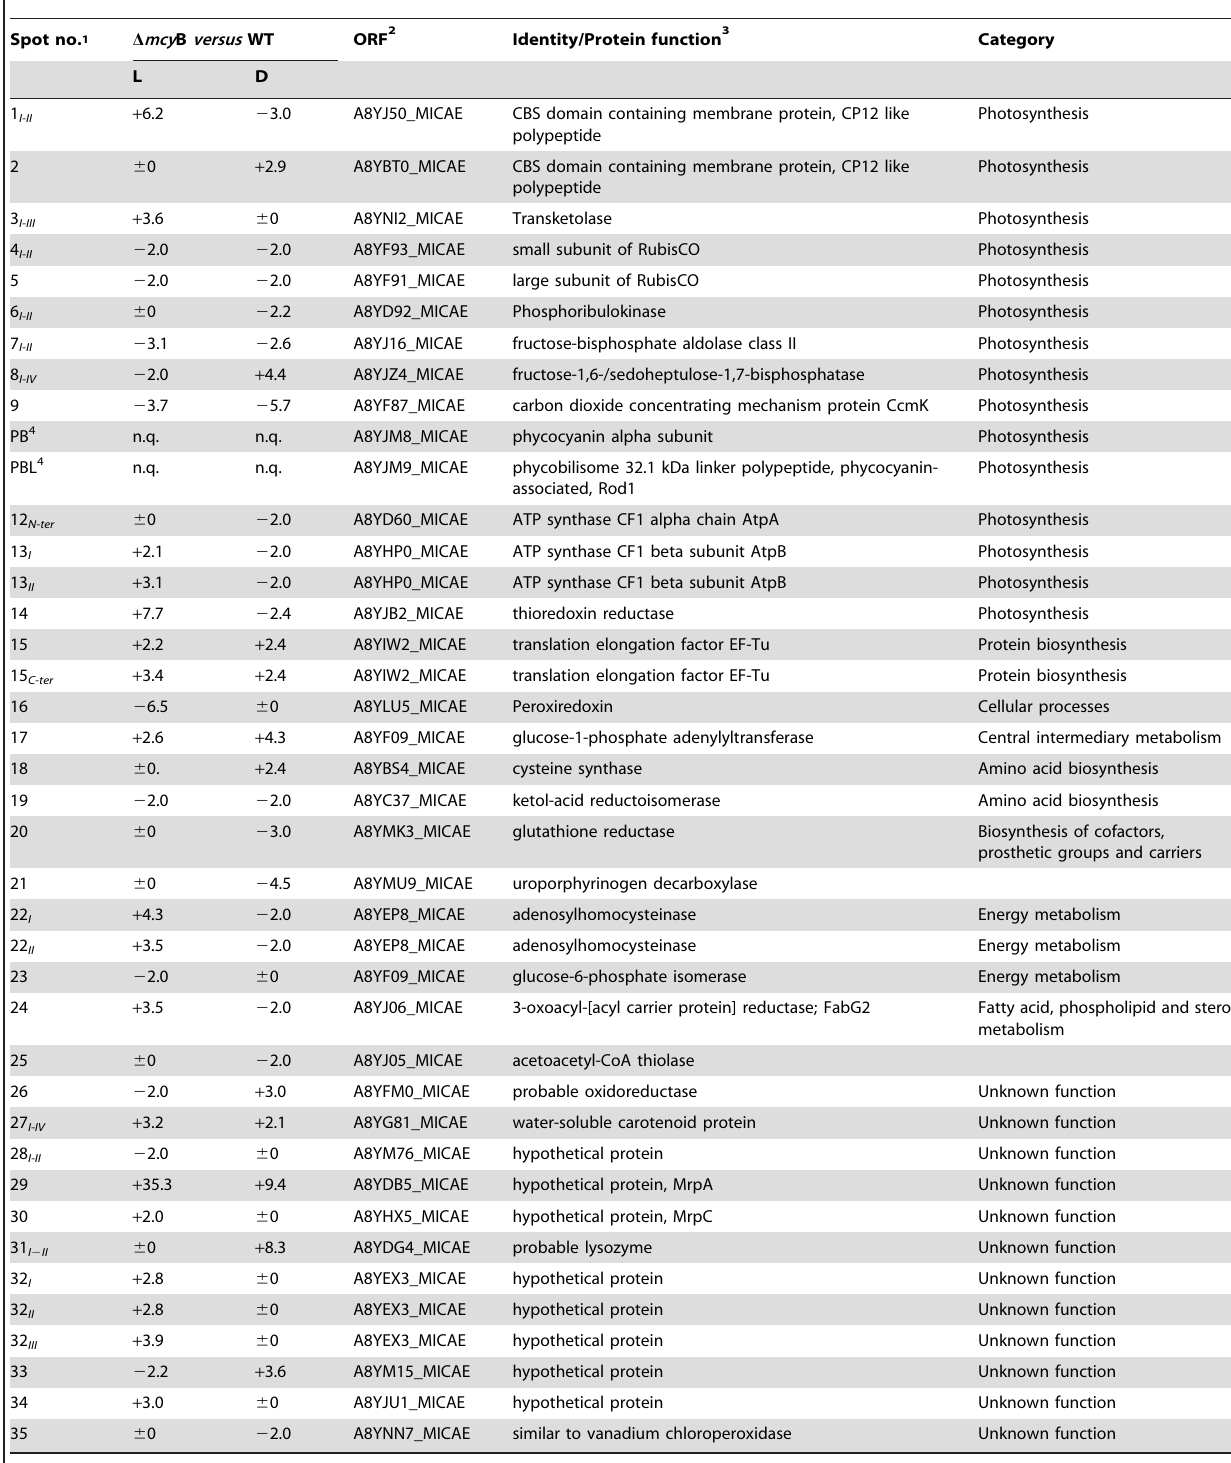
Table 1. List of proteins accumulated or repressed more than two-fold in the microcystin free D mcy B mutant in comparison to wild type M. aeruginosa PCC 7806 (WT) after short term exposure to high light (L) or dark (D) conditions.